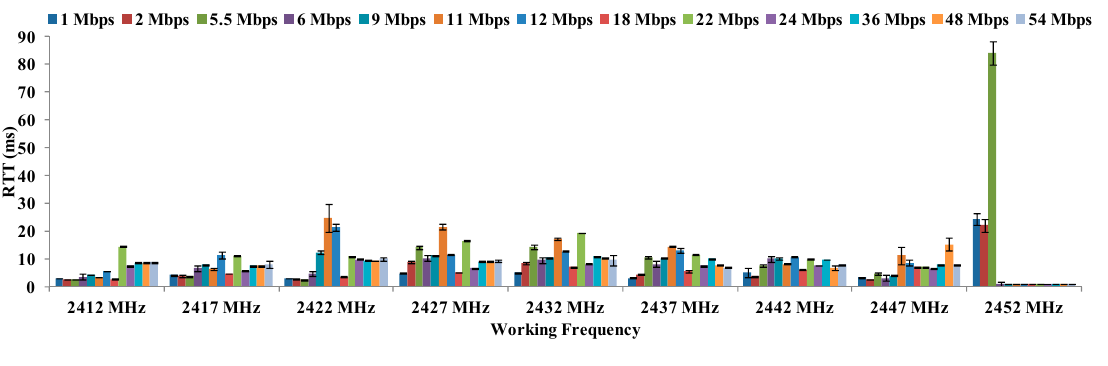
Figure 16. Measurements of RTT in ms for 18 °C.